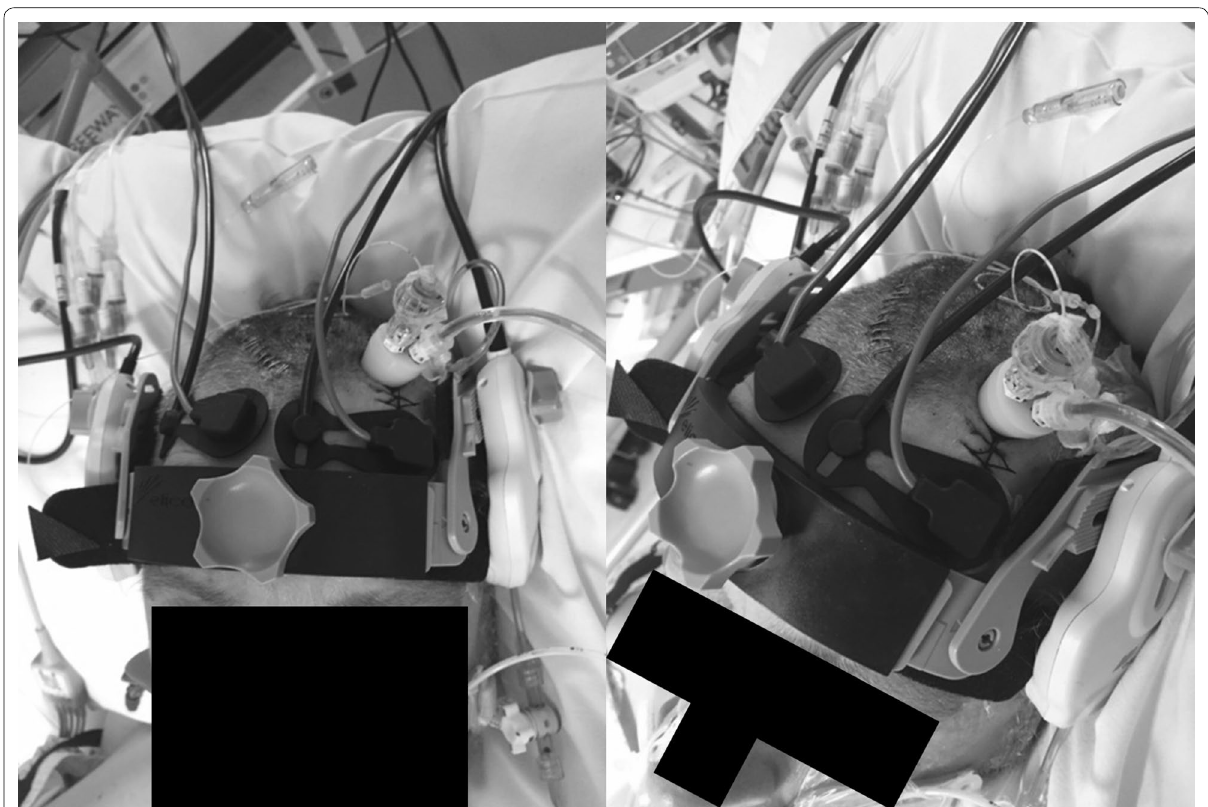
Fig. 4 Application of Robotic TCD System in TBI patient with multi-modal monitoring. Patient has triple bolt located in left frontal area, with bifrontal NIRS pads applied (all images). Delica TCD head-band can be seen crossing the forehead, just above the orbital rims. Wheel for ratchet tightening of head-band can be seen (both upper left and right images). Robotic drive/TCD probe can be seen over transtemporal window, insonating the MCA (upper right and lower left